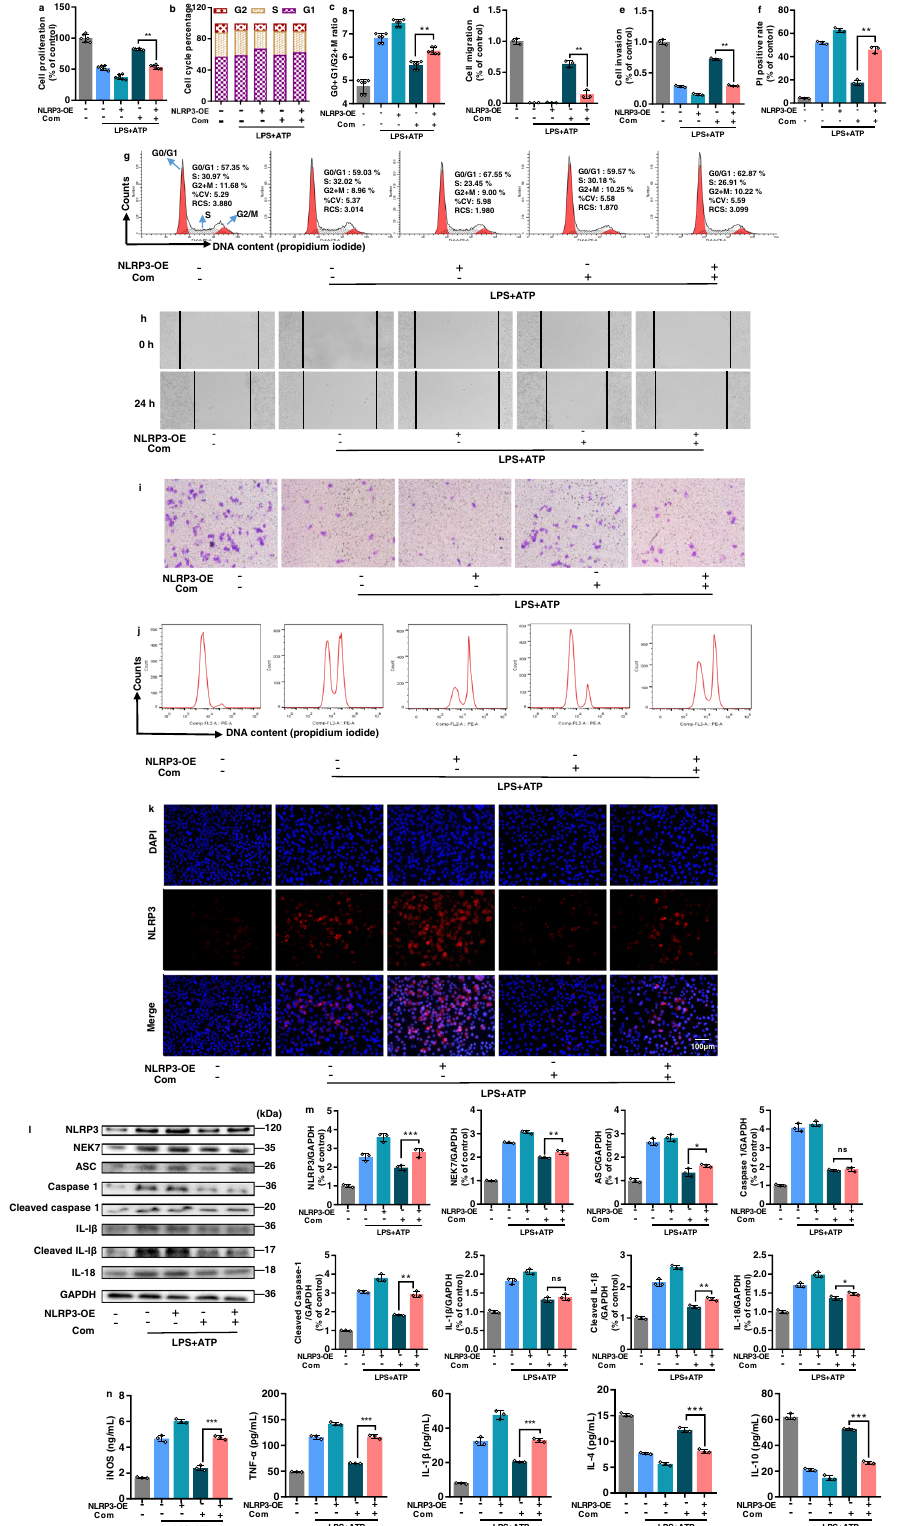
Fig. 6 Overexpression of NLRP3 counteracted the immunomodulatory activity of the combination in LPS/ATP-stimulated RAW264.7 macrophages. a Cell proliferation ( n = 6), b , c , g cell cycle ( n = 6), d , h cell migration, e , i cell pyroptosis, f , j cell apoptosis, k immunostaining assay for activated NLRP3. l , m Western blot assay for determining protein expressions of NLRP3, NEK7, ASC, caspase-1, cleaved caspase-1, IL-1 β , cleaved IL-1 β and IL-18 in cells lysates (GAPDH was measured as the loading control). n ELISA for the levels of pro-in fl ammatory (iNOS, TNF- α and IL-1 β ) and anti-in fl ammatory (IL-4 and IL-10) cytokines in cell supernatants ( d – n , n = 3). All data are expressed as mean ± SD. * P < 0.05, ** P < 0.01; ns represents no signi fi cant